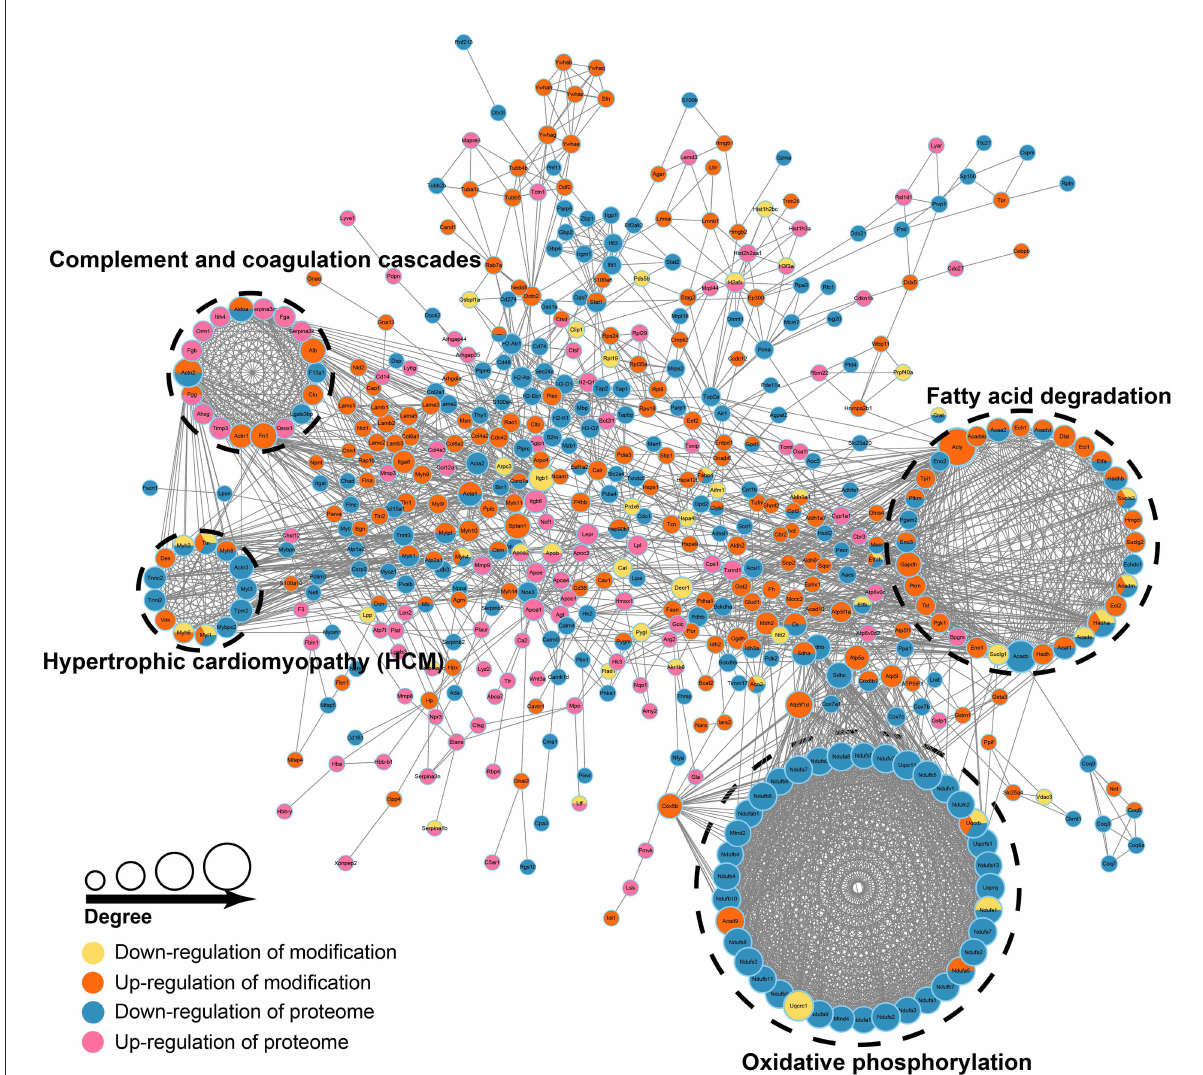
FIGURE5 Proteomics and acetylomics associative analysis. The size of the circle represents the value of degree (number of proteins interacting with differentially expressed proteins), the larger the circle, the higher the degree. The colors of the circle represent up/downregulation in proteome and